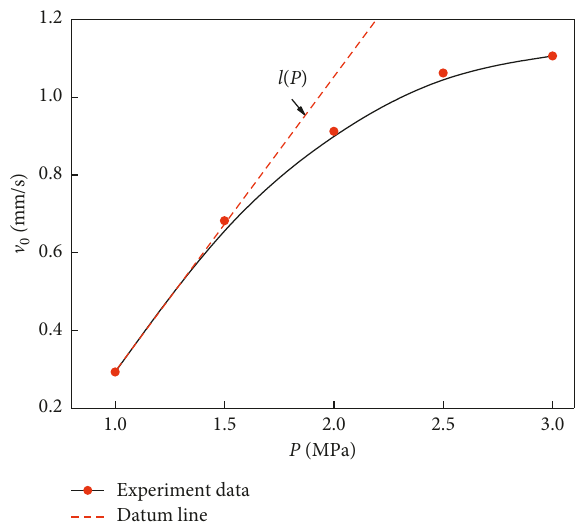
Figure 5: The variation curve of seepage velocity with the variation of seepage pressure.